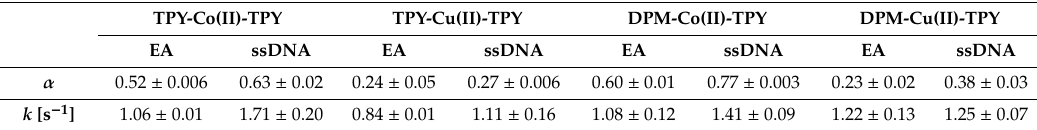
Table 3. Electron transfer coe ffi cients α and electron transfer rate constants k [s − 1 ] calculated for modified gold electrodes.